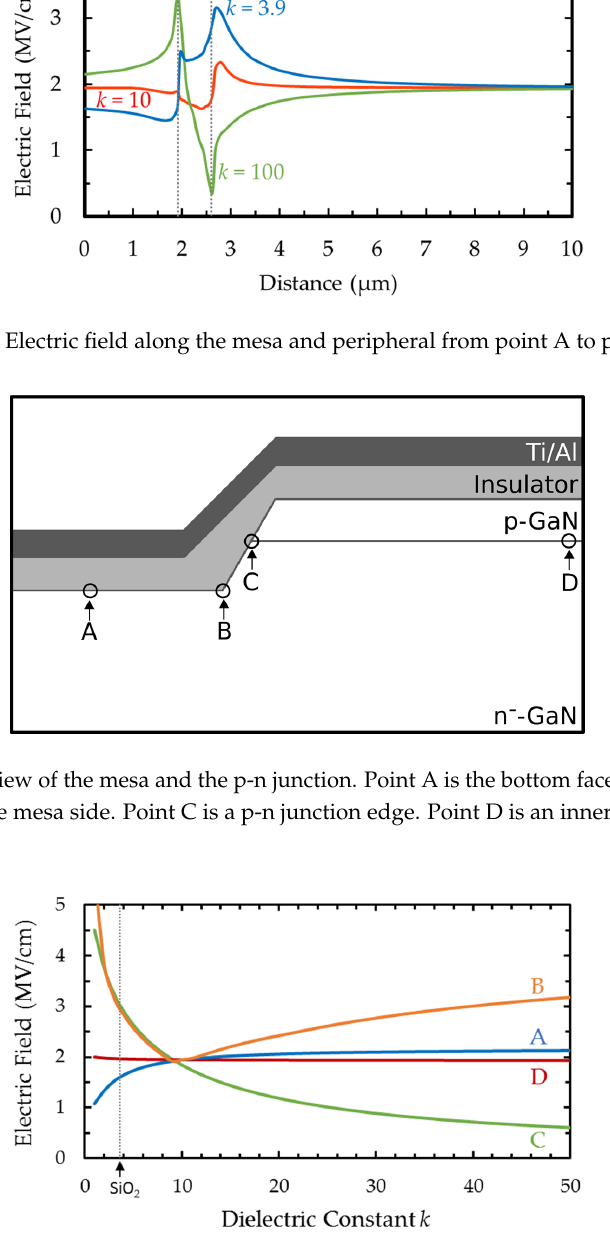
Figure 2. Simulation result at the mesa and peripheral: ( a ) k = 3.9 (SiO 2 ); ( b ) k = 10; ( c ) k = 100.